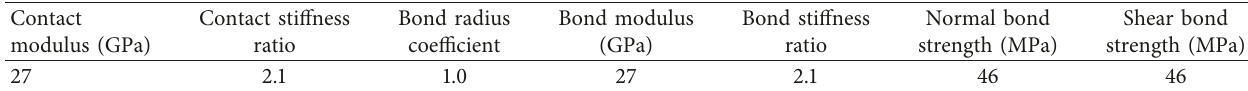
Figure 1: Binary-medium specimens. Table 1: Microscopic parameters for rock